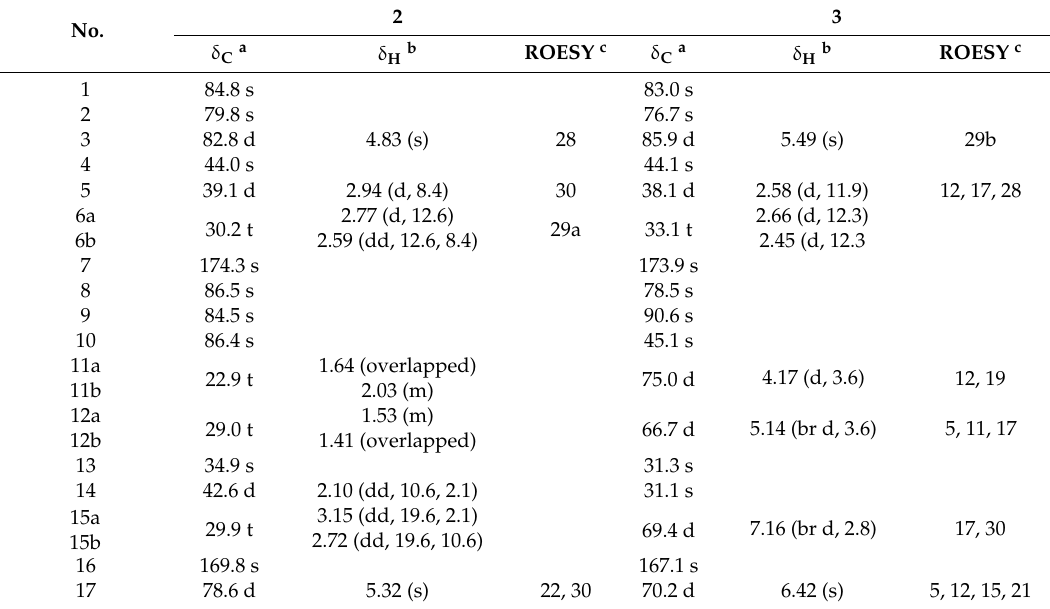
Table 2. NMR spectroscopic data of compounds 2 and 3 in CDCl 3 ( δ in ppm, J in